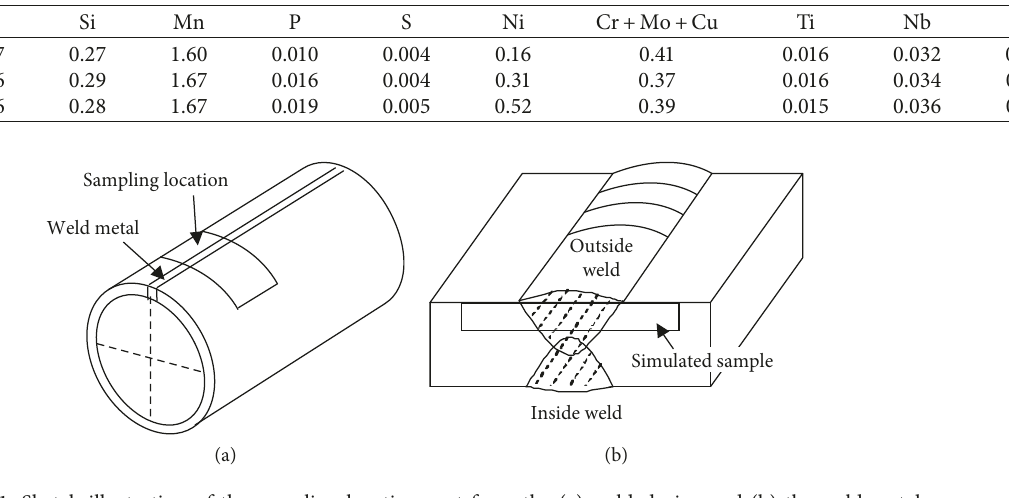
Table 1: Chemical composition of the weld metal for hot bends (wt.%).